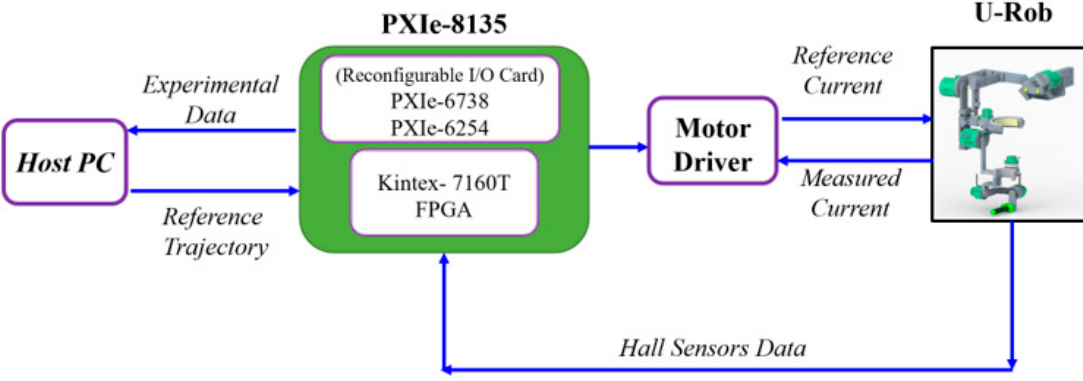
Figure 16. Schematic of the instrumentation for the control of